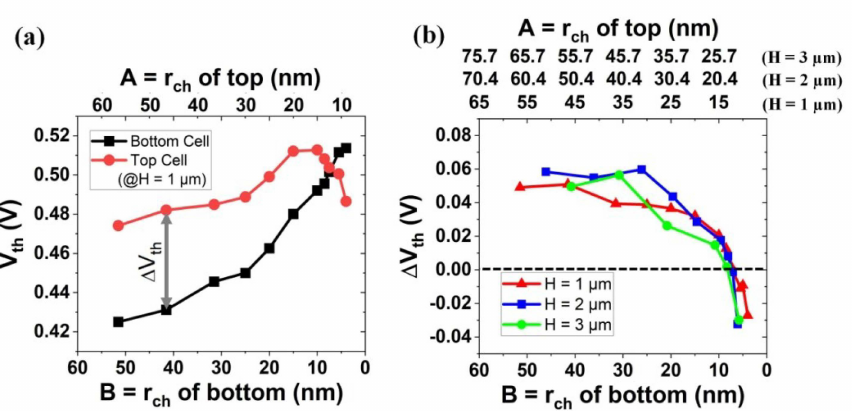
Figure 9. ( a ) Estimated threshold voltage (V th ) for various channel diameters. Note that V th for the top cell is higher (lower) than that for the bottom cell, if the channel radius of bottom cell (B) is longer (shorter) than ~10 nm. ( b ) Threshold voltage difference vs. channel radius, for a few given channel heights, i.e., 1 µ m, 2 µ m, and 3 µ m. ∆ V th is quite comparable, although the height becomes doubled or tripled. Note that the tapered angle, θ , is set to 0.3 ◦